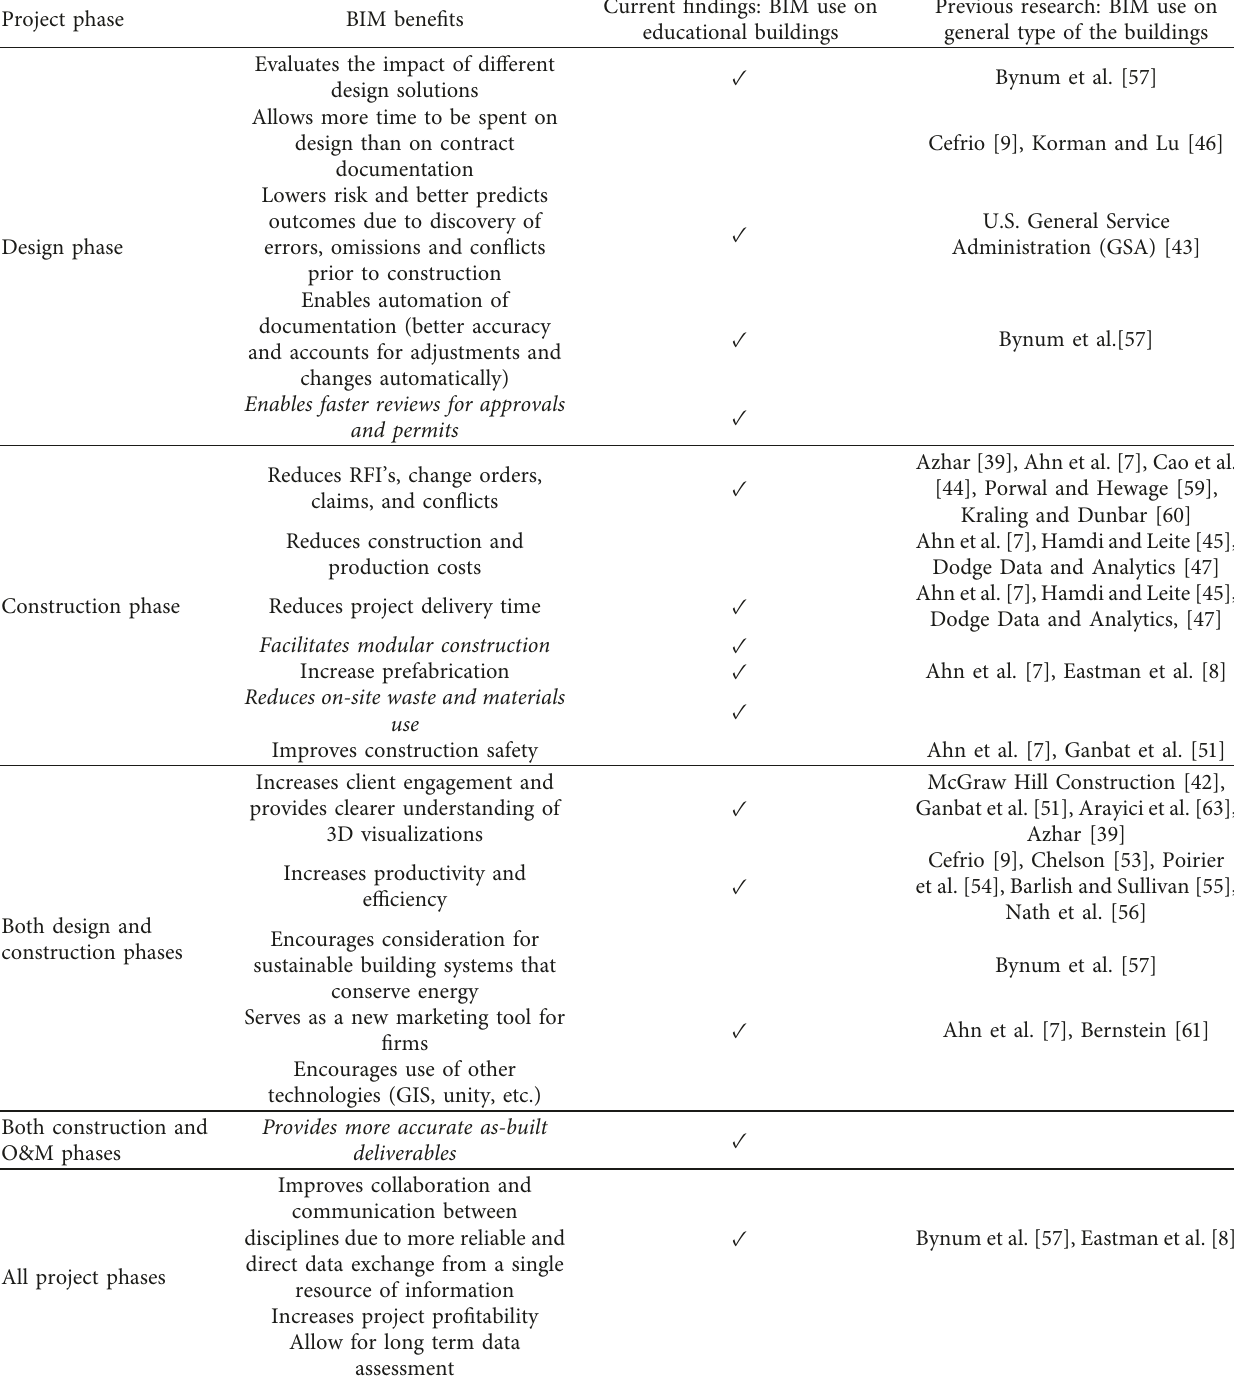
Table 13: Comparison of current findings and previous research: benefits of BIM